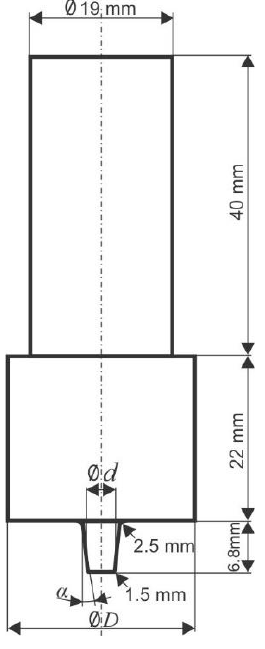
Figure 2. The used tool for the FSW